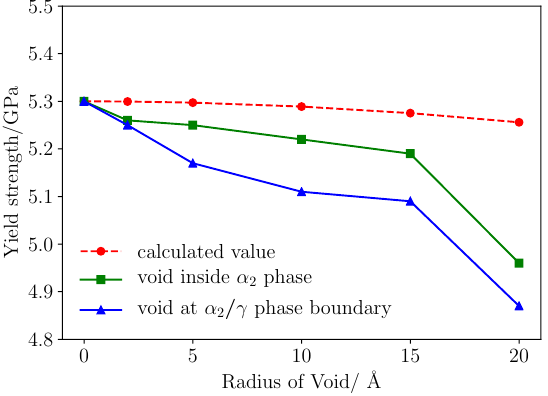
Figure 10. Yield strength of the materials with different size